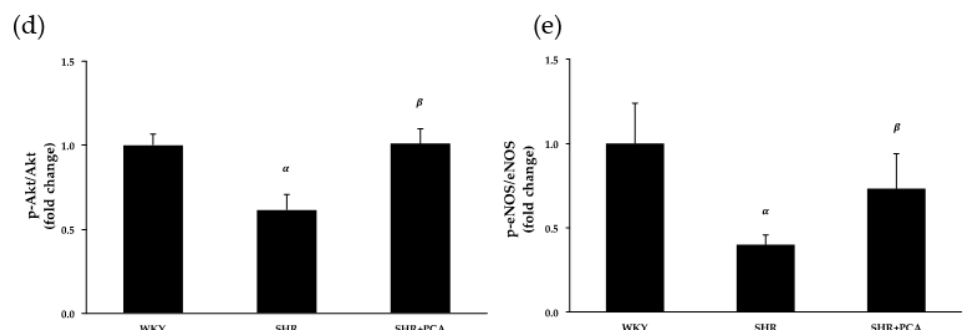
Figure 4. ( a ) Representative immunoblots of insulin receptor (insulin R), insulin-like growth factor-1 receptor (IGF-1 R), phospho-protein kinase B (p-Akt), protein kinase B (Akt), phospho-endothelial nitric oxide synthase (p-eNOS), endothelial nitric oxide synthase (eNOS), and actin extracted from thoracic aortas, and relative protein quantification of ( b ) insulin R, ( c ) IGF-1 R, ( d ) p-Akt/Akt, and ( e ) p-eNOS/eNOS on the basis of actin among the WKY, SHR, and SHR+PCA groups. α , p < 0.05, significant differences from WKY; β , p < 0.05, significant differences from SHR; n = 6 in each group.